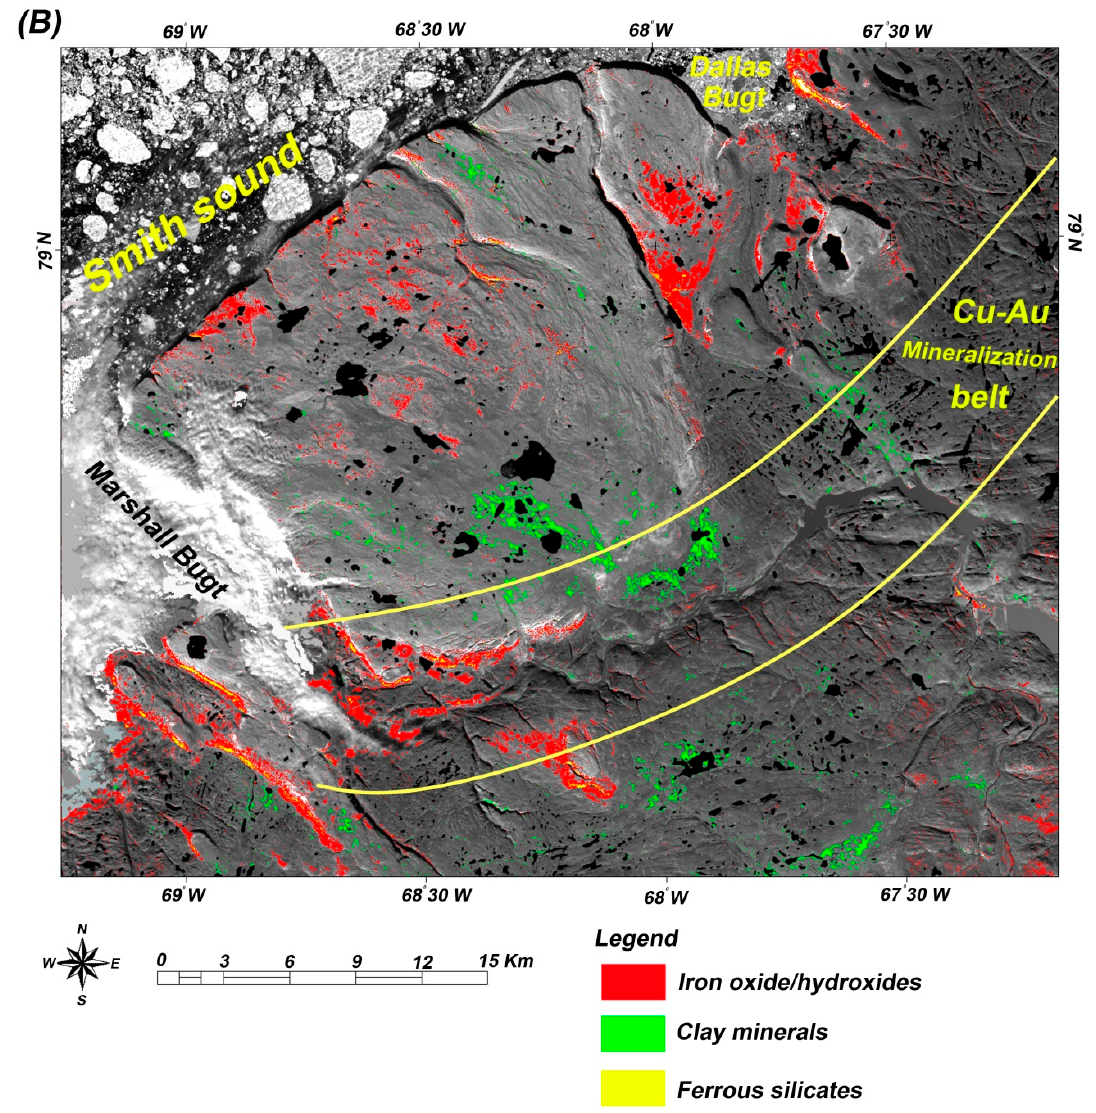
Figure 6. ( A ) The n-D classes (end-member spectra) extracted for a selected spatial subset (Landsat-8) covering Cu-Au mineralization belt and surrounding areas. Landsat-8 band center positions are shown. ( B ) LSU mineral map produced from fraction images overlaid on band 5 of Landsat-8 for the selected spatial subset covering the Cu-Au mineralization belt and surrounding areas.